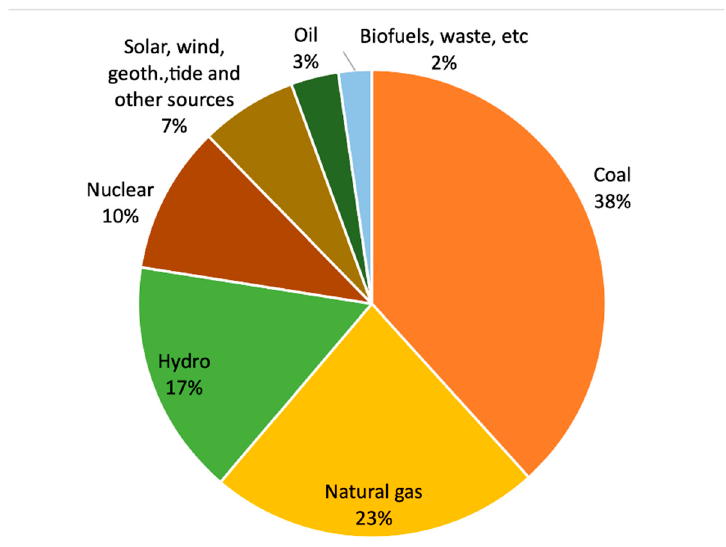
Figure 2. World electricity matrix in 2017. Data Source:[8].